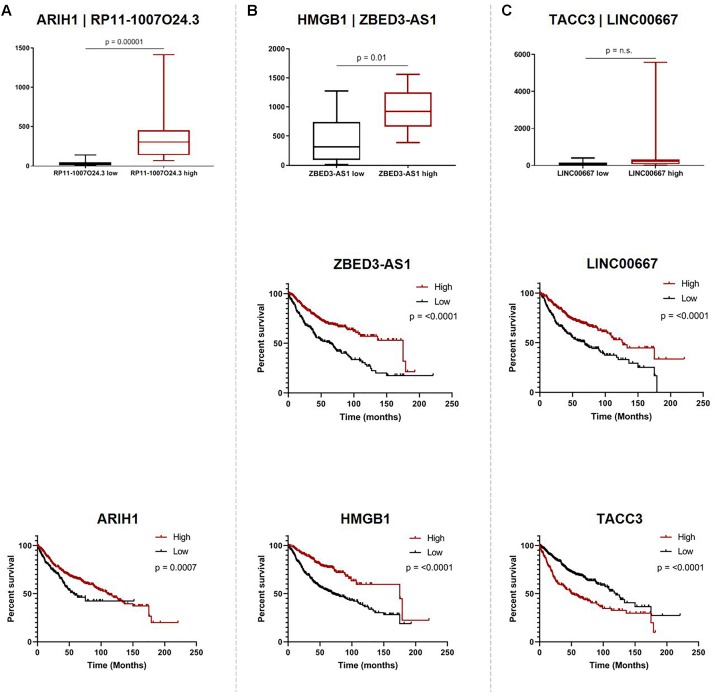
Associations of pseudogene-derived lncRNAs (upper row), their respective parent gene expression levels and their potential impact on patient outcome (middle row and bottom row). Expression and survival associations as seen for: (A)
RP11-1007O24.3 and parent gene ARIH1, (B)
ZBED3-AS1 and parent gene HMGB1, and (C)
LINC00667 and parent gene TACC3. Expression associations (upper row) for each pseudogene-derived lncRNA and parent gene pair were found by stratifying samples into tertiles by high (red) and low (black) expression of the pseudogene-derived lncRNA, and plotting the expression of the parent-gene (RPKM) on the y-axis. Survival associations were found for pseudogene-derived lncRNAs (middle row) and their respective parent genes (bottom row). Samples were stratified into tertiles with high (red) and low (black) expression of the gene-of-interest, and the significance of the associations were assessed using the logRank method through GraphPad Prism 8 software on data obtained from kmPlot (n = 673). Survival information was not available for RP11-1007O24.3 and it was thus omitted from this analysis.